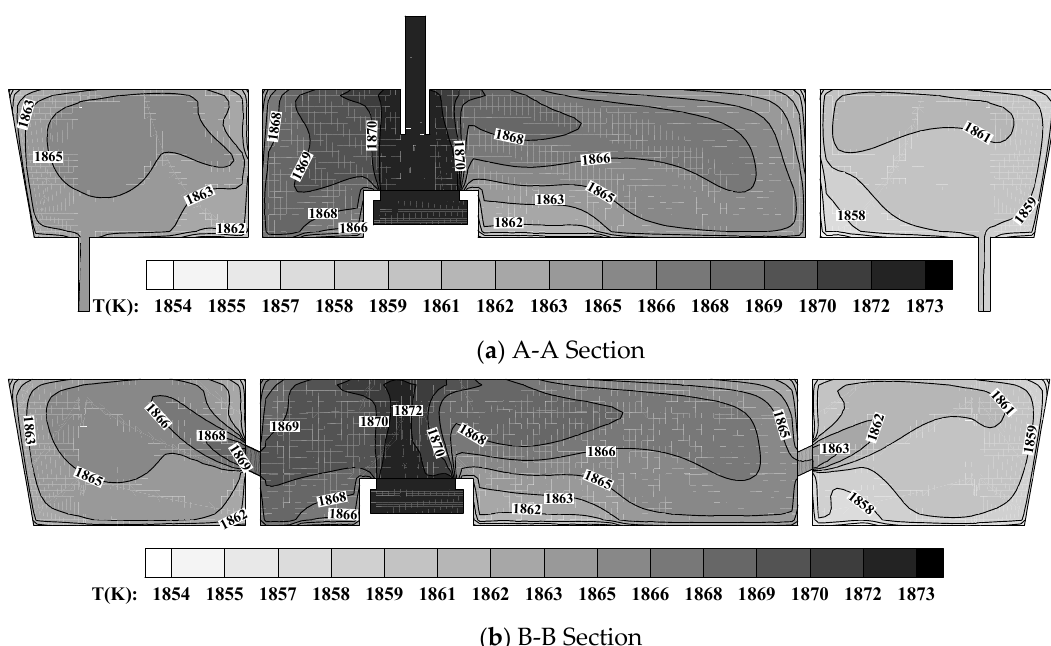
Figure 9. Temperature field in the optimized tundish.